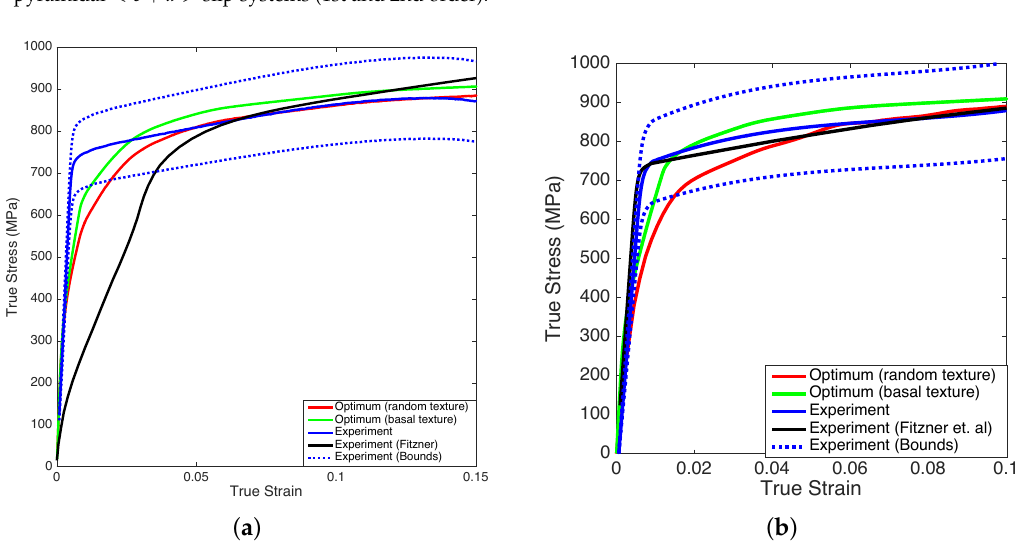
Figure 4. True strain-true stress curve comparison of experimental data and optimum design for Ti-7Al. ( a ) Tension curve; ( b ) Compression